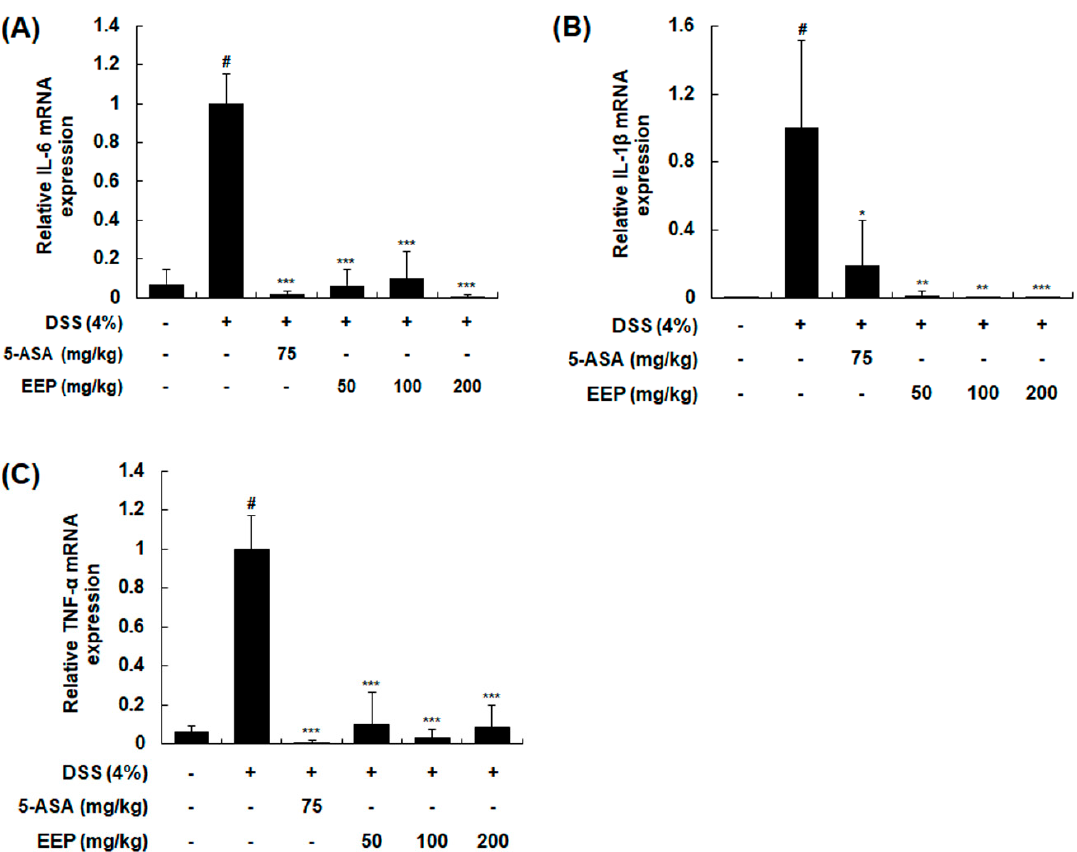
Figure 4. Effects of EEP on mRNA expression levels of pro-inflammatory cytokines in DSS-induced colitis mice. Colonic tissues were obtained after 9 days of DSS treatment and total RNAs were prepared for qRT-PCR. mRNA expression levels of IL-6 ( A ), IL-1 β ( B ), and TNF- α ( C ) were determined using specific primers and normalized against β -actin. Values are presented as means ± SDs ( n = 10). # p < 0.05 compared with the vehicle-treated control group, and * p < 0.05, ** p < 0.01, *** p < 0.001 compared with the DSS-induced colitis